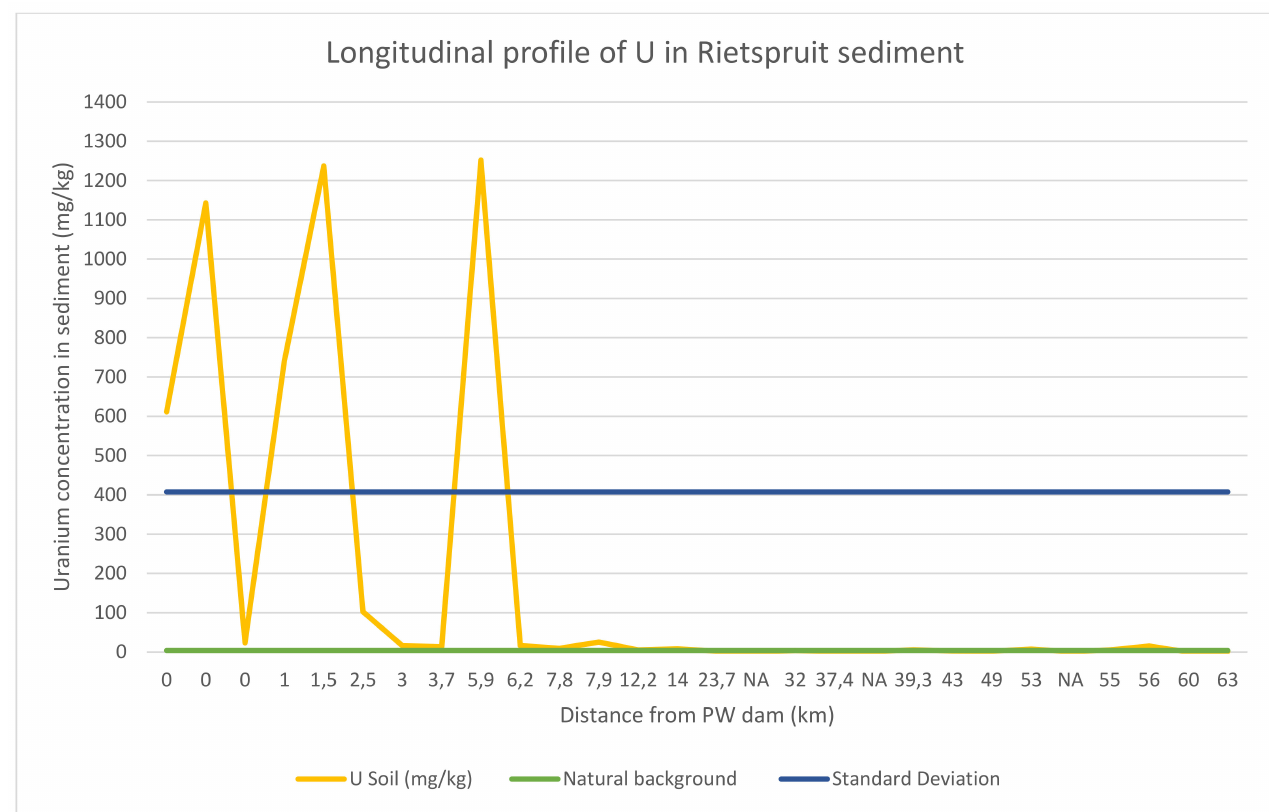
Figure 5. Longitudinal profile of U in Rietspruit